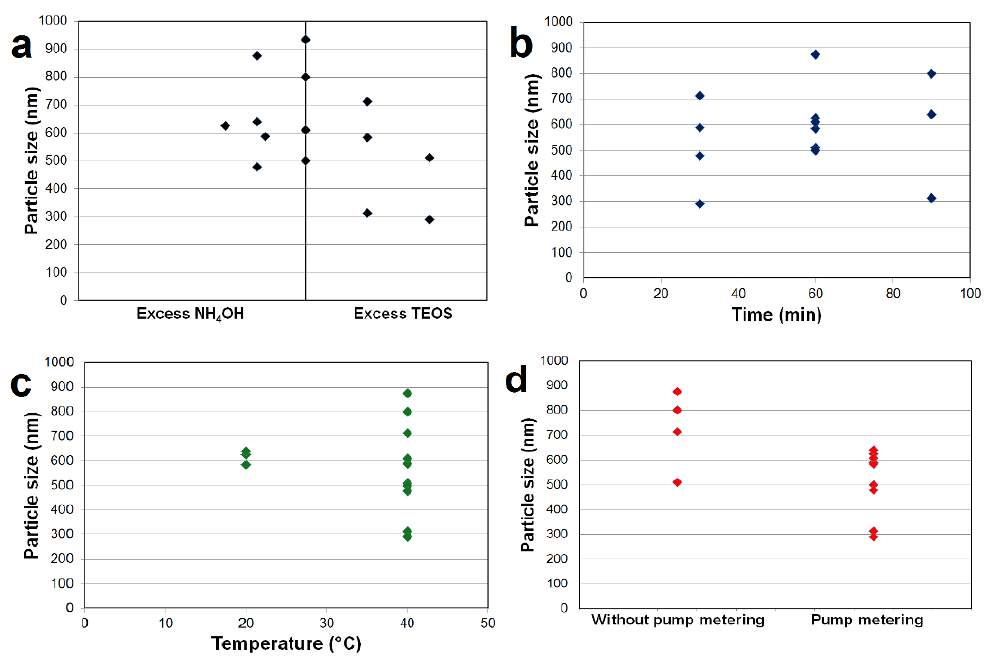
Figure 1. Results of statistical analysis. Particle size distribution versus the following initial variables: (a) excess of one of the reagents, (b) time, (c) temperature, and (d) mode of TEOS